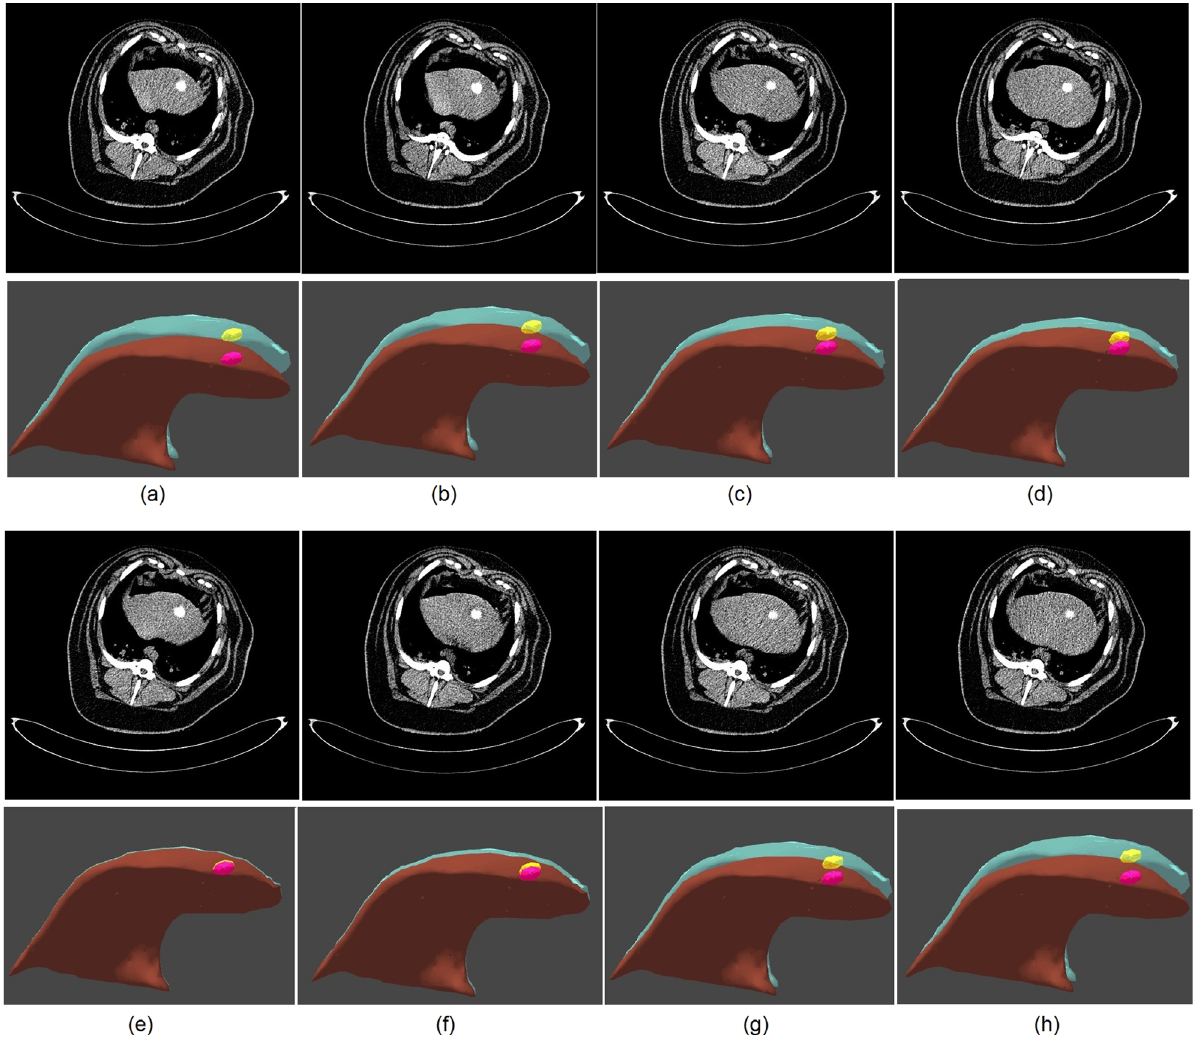
Fig. 4 Patient-specific respiratory motion reconstruction. The red region shows the shape of the liver at the fully inhalation stage, while the light blue part region shows the shape of the liver at different respiration stage.